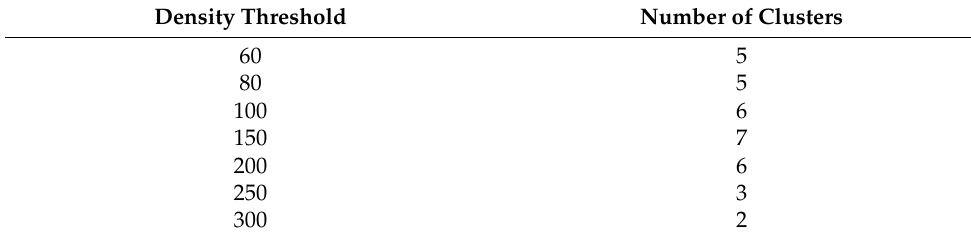
Table 7. Radius length = 0.025.